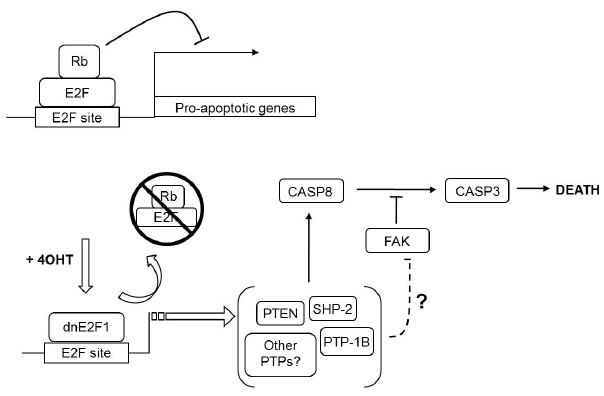
Figure 6. Overview of the Rb/E2F-associated apoptotic path- way. Active Rb/E2F complexes bind to E2F sites within the promoters of several pro-apoptotic genes, repressing their transcription. Treat- ment of the U2OS ER-dnE2F1 cell line with 4-OHT results in the translocation of dnE2F1 to the nucleus where it displaces Rb/E2F complexes from their binding sites. The loss of Rb/E2F repression leads to the up-regulation of PTP-1B, SHP-2, and PTEN (and potentially other phosphatases), dephosphorylation of FAK, and stimulation of apoptosis through activation of caspase-8.